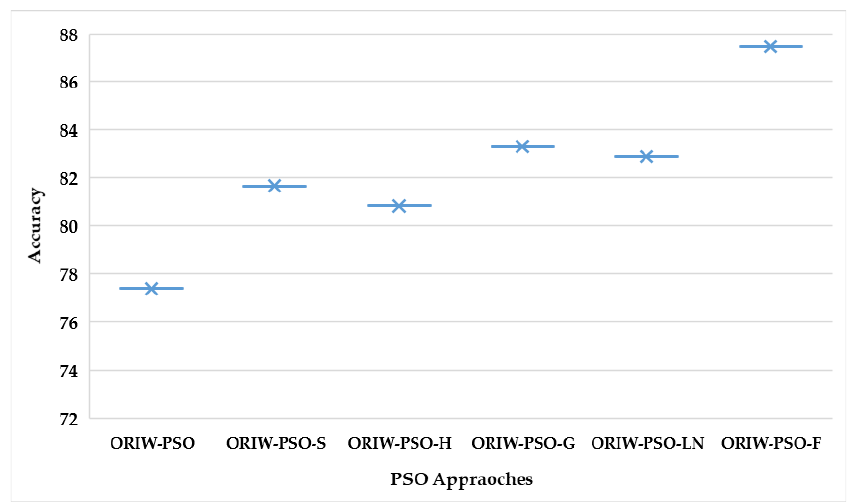
Figure 14. Result of one-way ANOVA test on testing accuracy.